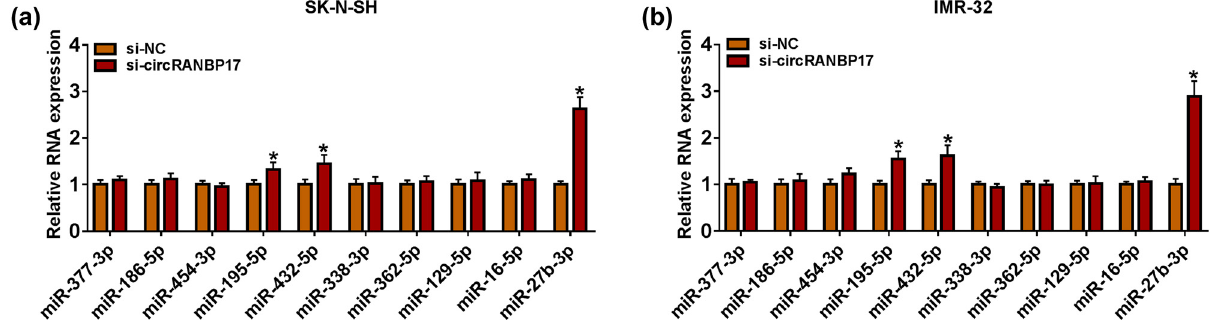
Figure A1: The miRNAs with circRANBP17 - binding sites and related to NB progression were analyzed by qRT - PCR after circRANBP17 depletion in SK - N - SH ( a ) and IMR - 32 cells ( b ) . * P < 0.05.